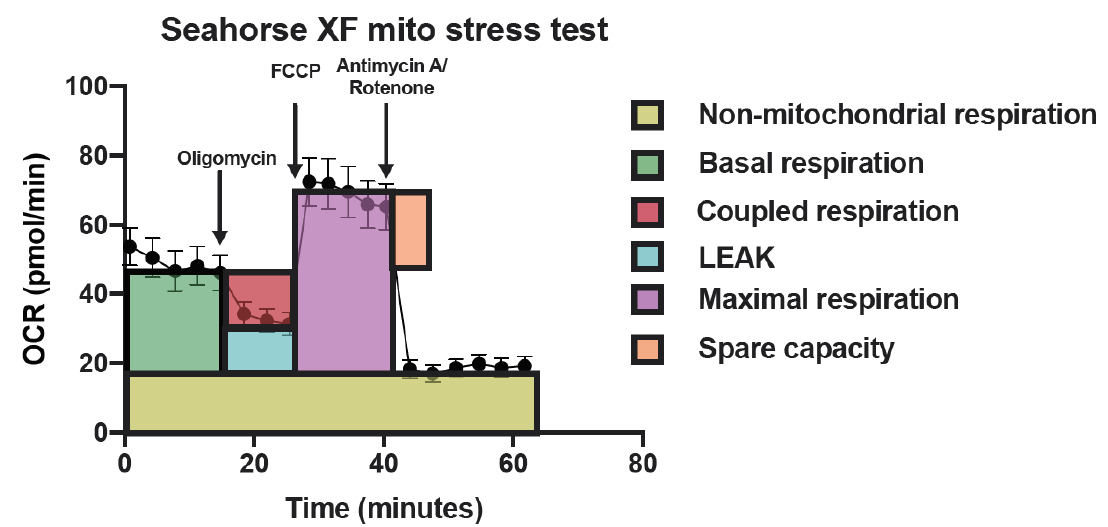
Figure 5. Graphical overview of measurements from the flux analysis. Graphical description of how calculations of the following mitochondrial parameters were made: non-mitochondrial respiration (values after antimycin A), basal respiration (baseline-antimycin A), coupled respiration (baseline-oligomycin), LEAK (oligomycin-antimycin A), maximal respiration (FCCP-antimycin